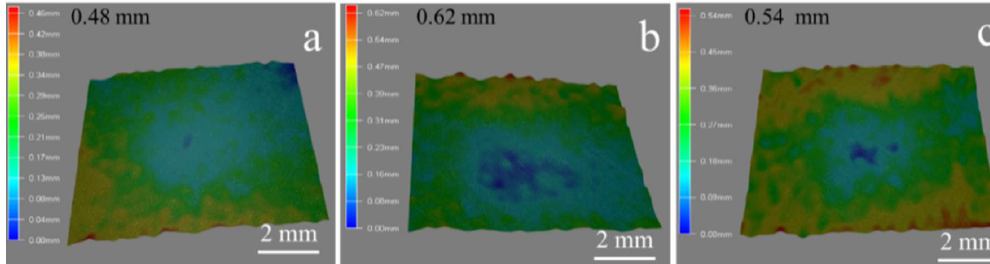
Figure 10. Three-dimensional picture of CF / PC composites at same experimental conditions after sand erosion. ( a ) un-aged composites surface after erosion at an angle of 60°, ( b ) hydrothermal aged for 7 days composites surface after erosion at an angle of 60°, ( c ) hydrothermal aged for 42 days after erosion at an angle of 60°.